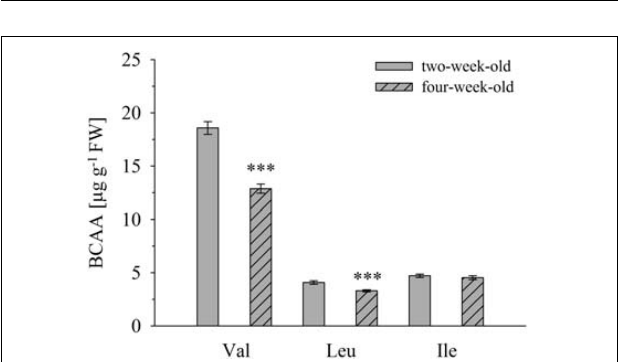
FIGURE 5 | Branched-chain amino acid determination in A. thaliana accession Col-0 of 2- and 4-week-old plants. Amino acid concentrations were determined in leaves of 2- and 4-week-old seedlings. Means ± SE ( n = 9–10) are plotted. Asterisks indicate statistically significant differences compared to 2-week-old plants ( t- test). ∗∗∗ p <